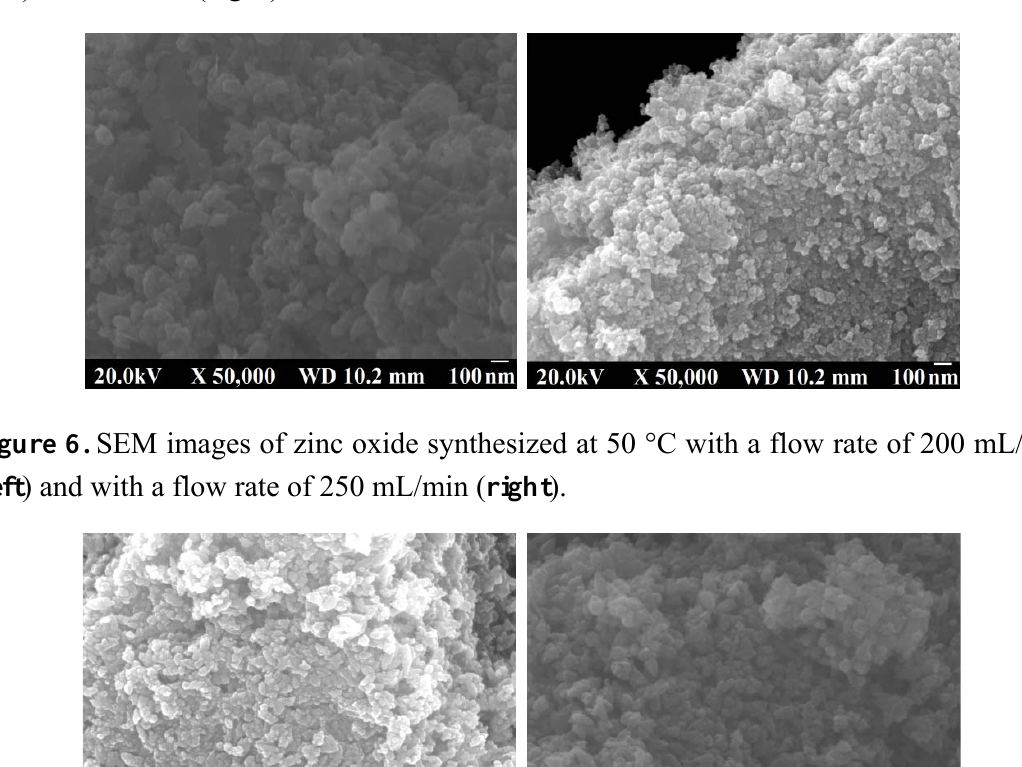
Figure 5. SEM images of zinc oxide synthesized with a flow rate of 200 mL/min at 25 °C ( left ) and at 75 °C ( right ).